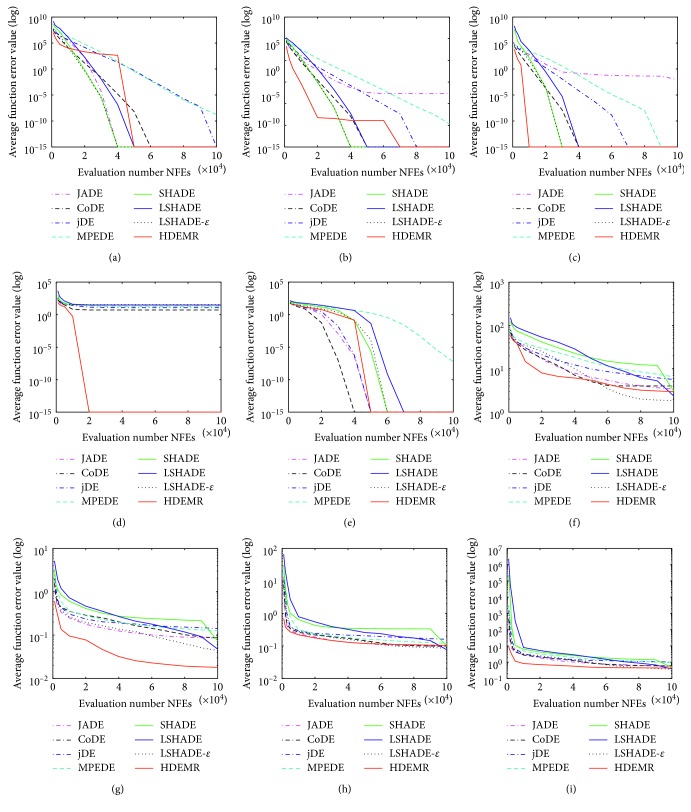
The convergence graphs on different types of CEC2014 benchmark functions. (a) The convergence graph on the unimodal function f1. (b) The convergence graph on the unimodal function f2. (c) The convergence graph on the unimodal function f3. (d) The convergence graph on the simple multimodal function f4. (e) The convergence graph on the simple multimodal function f8. (f) The convergence graph on the simple multimodal function f9. (g) The convergence graph on the simple multimodal function f13. (h) The convergence graph on the simple multimodal function f14. (i) The convergence graph on the simple multimodal function f15.